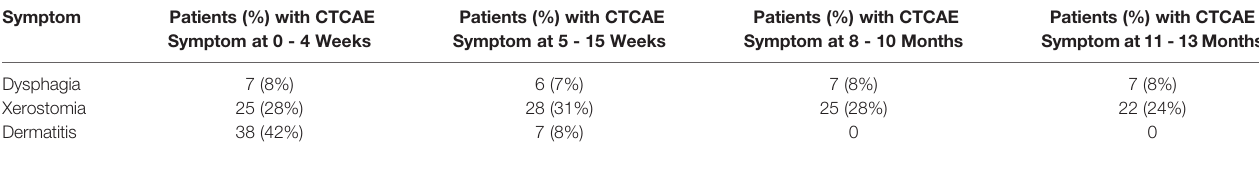
Patients (%) with CTCAE Symptom at 0 - 4 Weeks